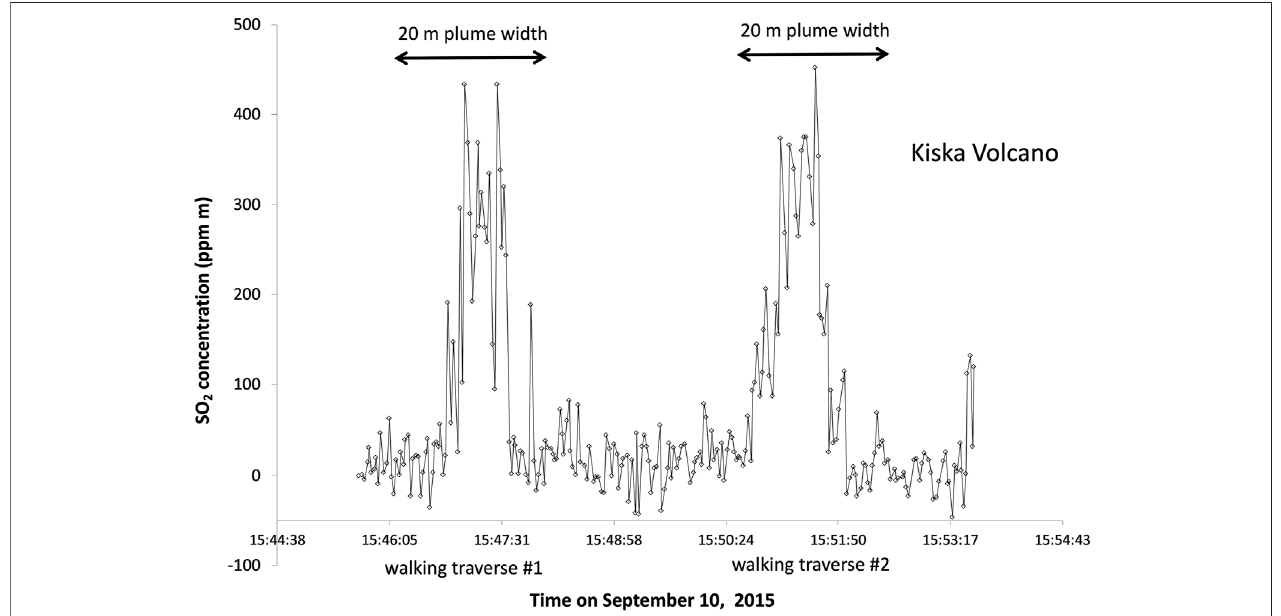
FIGURE 4 | Example of one walking traverse using the miniDOAS to measure SO 2 concentration in the Kiska fumarole plume.